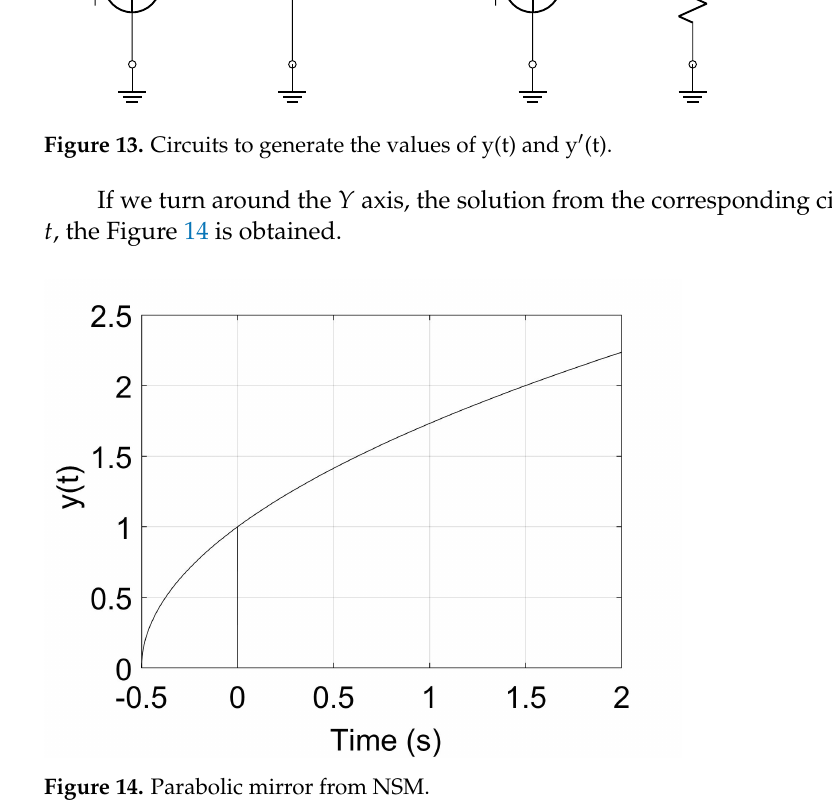
Figure 14. Parabolic mirror from NSM.